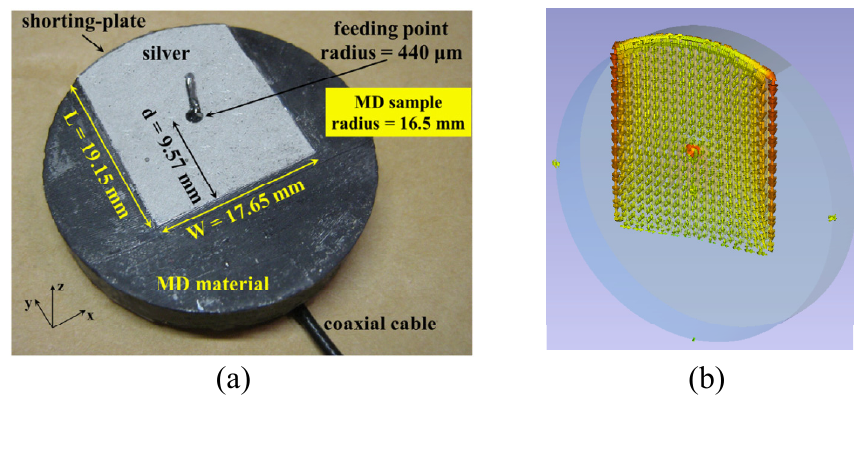
Figure 10. ( a ) Photo of the “button-shaped” patch antenna on a magneto-dielectric material. ( b ) Surface current distribution on patch metallization at 868